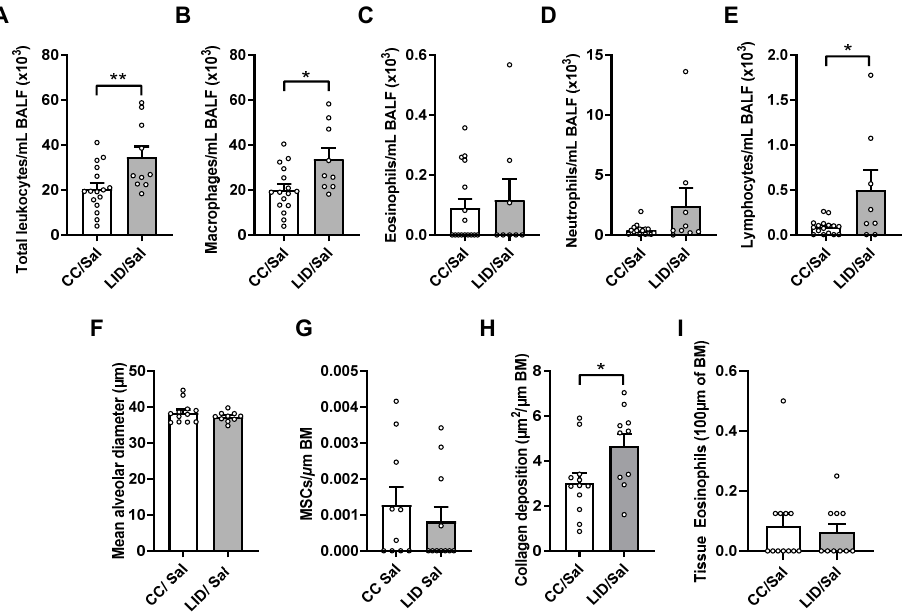
Figure 3. Low iron diet (LID) during pregnancy increases airway inflammation and collagen de- position in male and female offspring. ( A ) Total leukocytes, ( B ) macrophages, ( C ) eosinophils ( D ) neutrophils and ( E ) lymphocytes were enumerated in bronchoalveolar lavage fluid (BALF) at five weeks. Histopathology was assessed in terms of ( F ) mean alveolar diameter, ( G ) mucus secret- ing cells (MSCs) per µ m of basement membrane (BM), ( H ) small airway collagen deposition and ( I ) airway-associated eosinophils. n = 10–16 mice per group. Analysed by unpaired student t -test. Data are presented as mean ± SEM (* p < 0.05; ** p < 0.01).